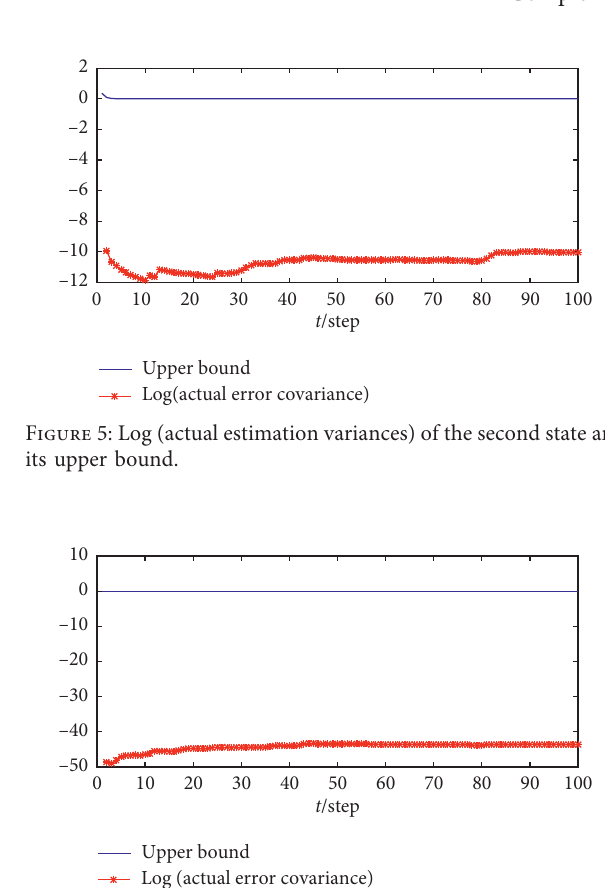
Figure 3: Actual fault and the estimated fault.